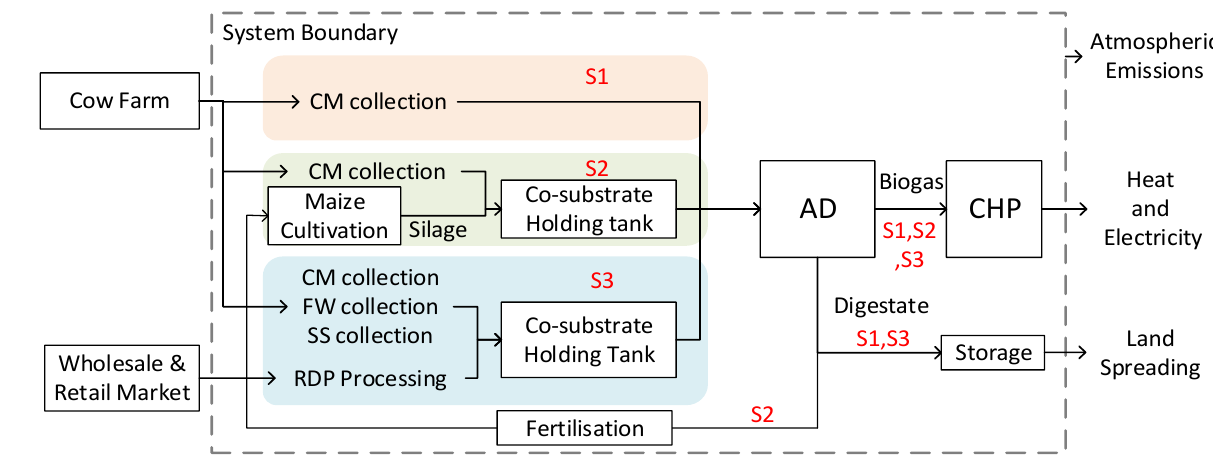
Figure 1. System Boundary of the study.